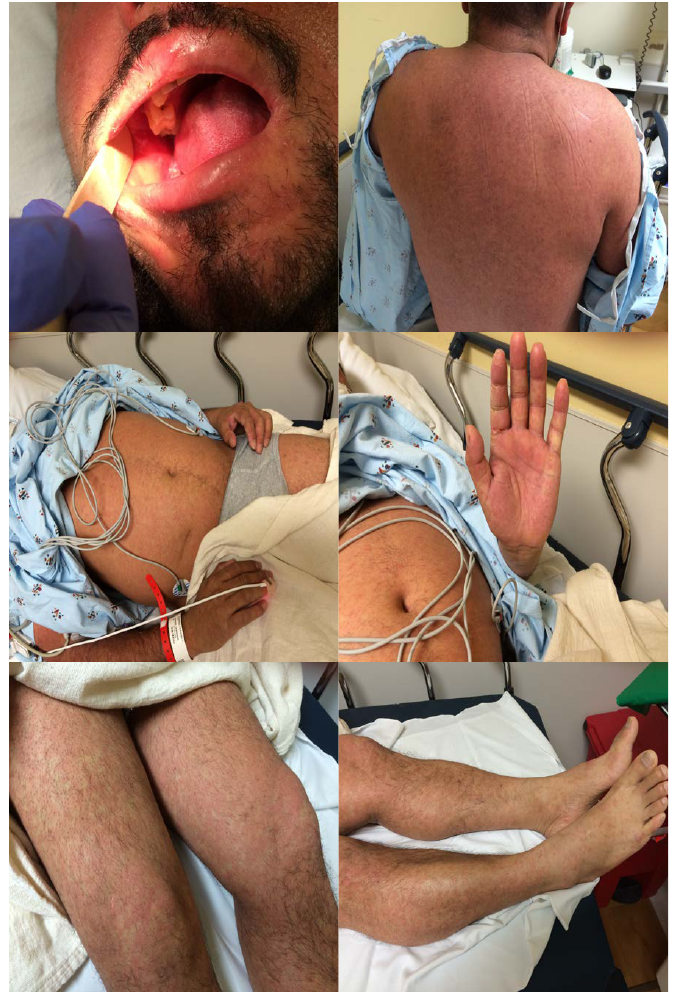
Figure 4. Measles rash and Koplik spots in an adult male. Photos used with permission of Michael J. Burns,